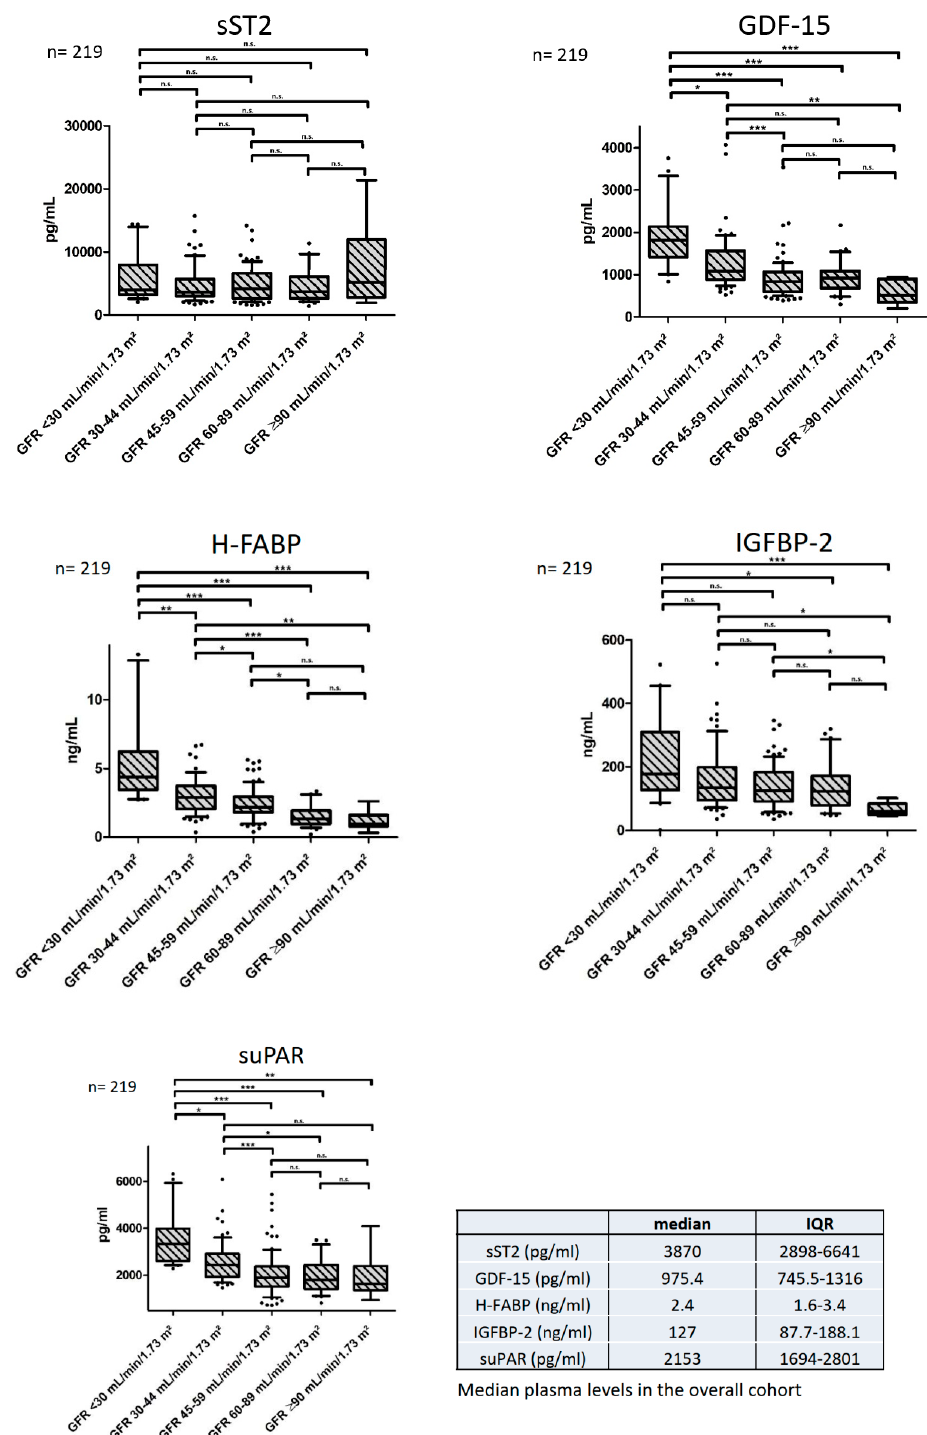
Figure 1. Biomarker concentrations throughout the stages of CKD. Median plasma levels and interquartile ranges (IQR) of the overall cohort are depicted in the additional table. * indicates a p of <0.05, ** a p of <0.01 and *** a p of <0.001, n.s.= not significant. Abbreviations: sST2 = soluble suppression of tumorigenicity, GDF-15 = growth differentiation factor 15, H-FABP = heart-type fatty acid binding protein, IGF-BP2= insulin-like growth factor binding protein 2, suPAR = soluble urokinase plasminogen activator receptor, eGFR = estimated glomerular filtration rate, IQR = interquartile range.